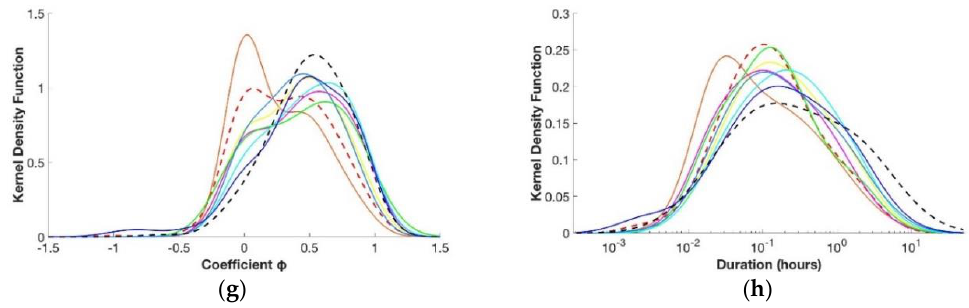
Figure 5. Estimated kernel density function of the four variables for the segments of the day in the upper part and for the segments of the night in the lower part. From above to down, left to right: ( a , e ) mean µ , ( b , f ) variance σ 2 , ( c , g ) coefficient ϕ , and ( d , h ) duration T. The groups considered are divided according to the number of inhabitants of the town in which the children lived as shown in Table 2.